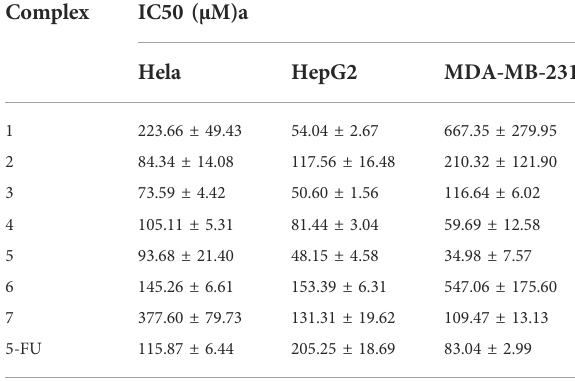
TABLE 1 IC50 values of all the complexes to the tumor cells. The results were represented as average values ± standard deviation. Data represent at least three independent